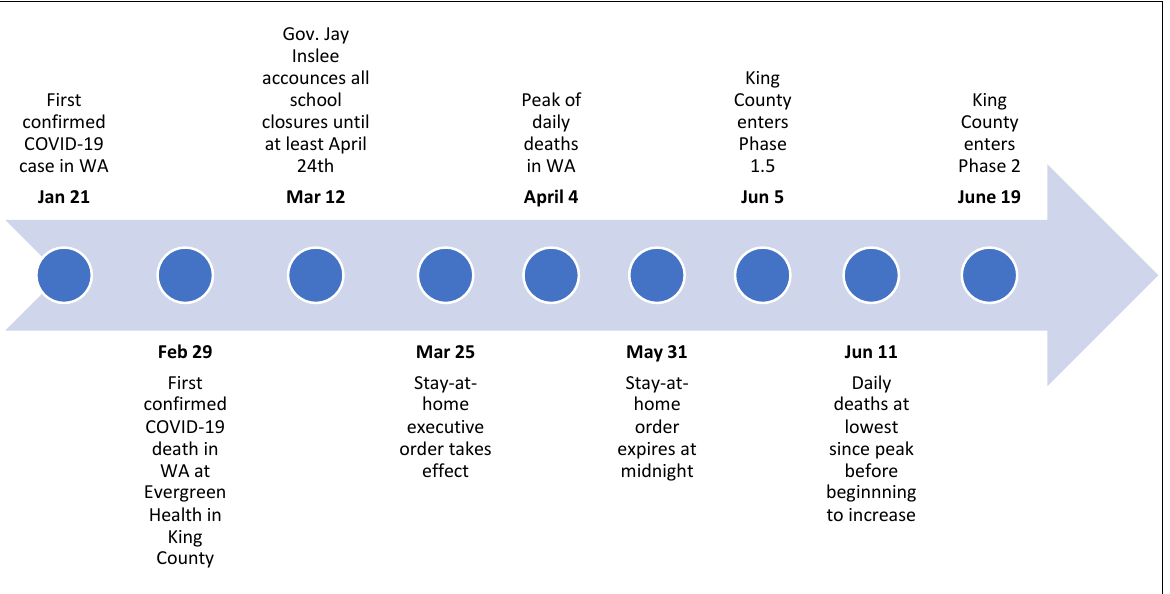
Figure 1. Timeline of COVID-19 in Washington from First Confirmed Case in the State to Entering Phase